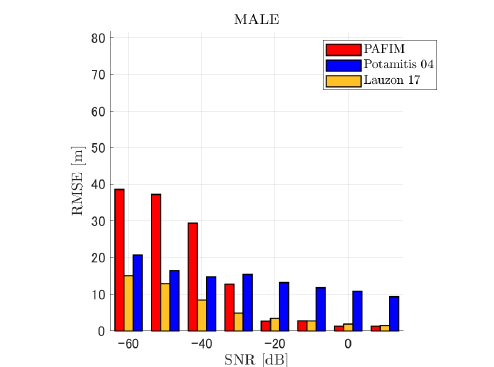
Figure 7. RMSE of tracking a stationary sound source emitting white noise.